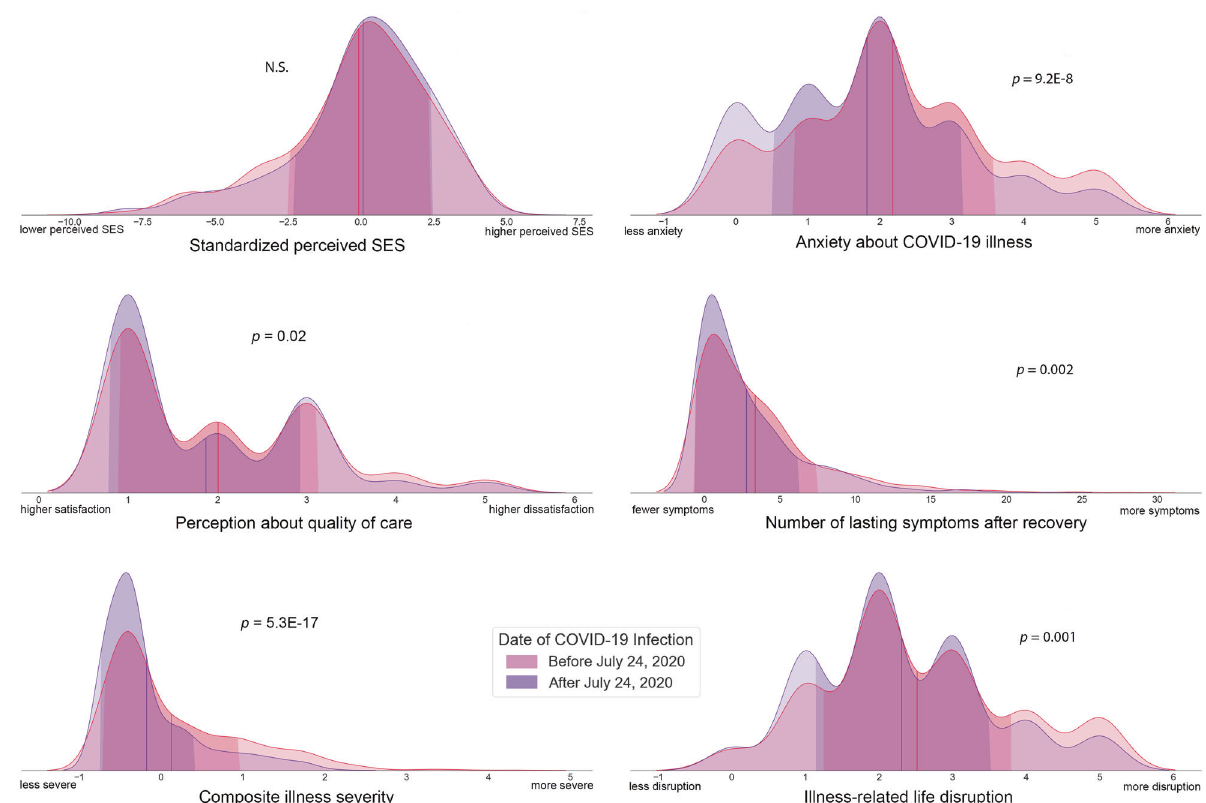
Fig. 2 Differences in patients infected early versus late in the COVID-19 pandemic. Comparisons between patients infected with COVID-19 early versus late in the pandemic yield mixed results. While groups do not differ greatly in demographics, there are a few pronounced differences in clinical and psychosocial factors, most notably self-reported illness severity and anxiety about COVID-19 illness. Vertical red and purple lines on each distribution plot represent group means for early versus late infection, respectively. Standard deviations for each group are indicated by the darker shading on each